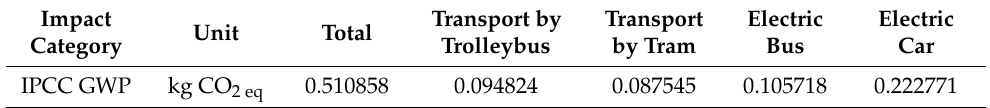
Table 11. The results of the analysis of the IPCC Global Warming Potential.